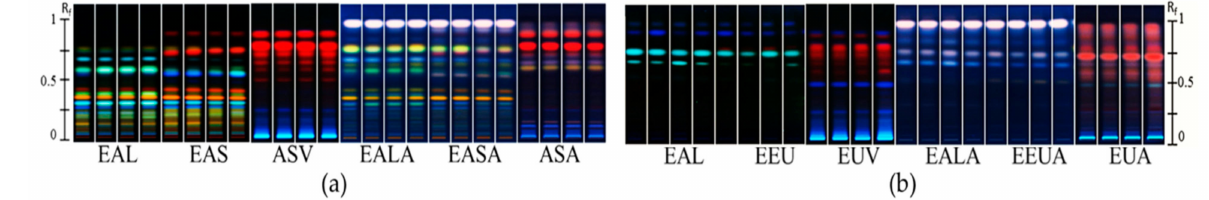
Figure 6. High performance thin layer chromatography analysis of mycelium extracts, visualized with ultra violet (UV) light at 366 nm with or without derivatization with sulfuric-anisaldehyde reagent. ( a ), Ethyl acetate extracts of mycelium of 11(2) fed with Alstonia scholaris methanol extract; EAL: mycelium extracts of 11(2) without extract feeding (negative control); EAS, mycelium extracts of 11(2) fed with methanol extract of A. scholaris ; ASV: ethyl acetate liquid-liquid extracts of A. scholaris ; EALA; mycelium extracts of 11(2) without extract feeding (negative control) after derivatization with sulfuric-anisaldehyde (Sa); EASA: mycelium extracts of 11(2) fed with methanol extract of A. scholaris after derivatization with Sa; ASA: ethyl acetate liquid-liquid extracts of A. scholaris after derivatization with Sa; ( b ), Ethyl acetate extracts of mycelium of EU11 fed with Euphorbia myrsinites methanol extract; EAL: mycelium extracts of EU11 without extract feeding (negative control); EEU: mycelium extracts of EU11 fed with methanol extract of E. myrsinites ; EUV: ethyl acetate liquid-liquid extracts of E. myrsinites ; EALA: mycelium extracts of EU11 without extract feeding (negative control) after derivatization with sulfuric-anisaldehyde (Sa); EEUA: mycelium extracts of EU11 fed with methanol extract of E. myrsinites after derivatization with Sa; EUA: ethyl acetate liquid-liquid extracts of E. myrsinites after derivatization with